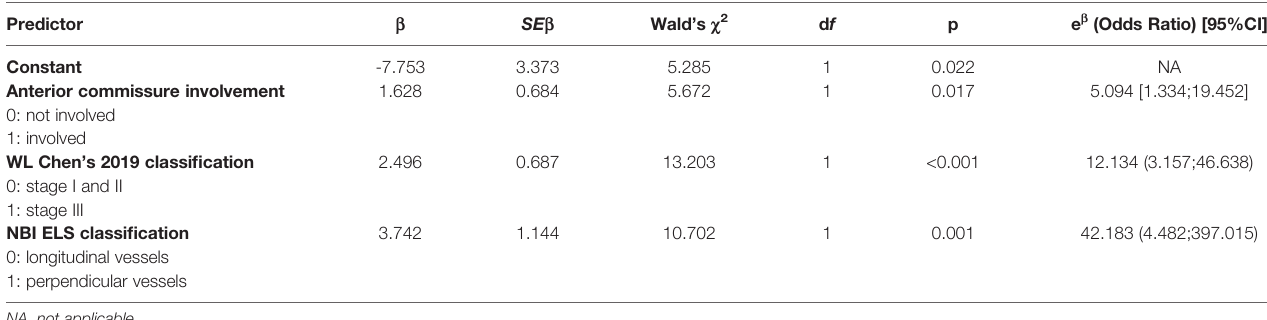
TABLE 2 | Summary of multivariate analysis using logistic regression, including the parameters for the regression model and goodness of fi t test results. Predictor